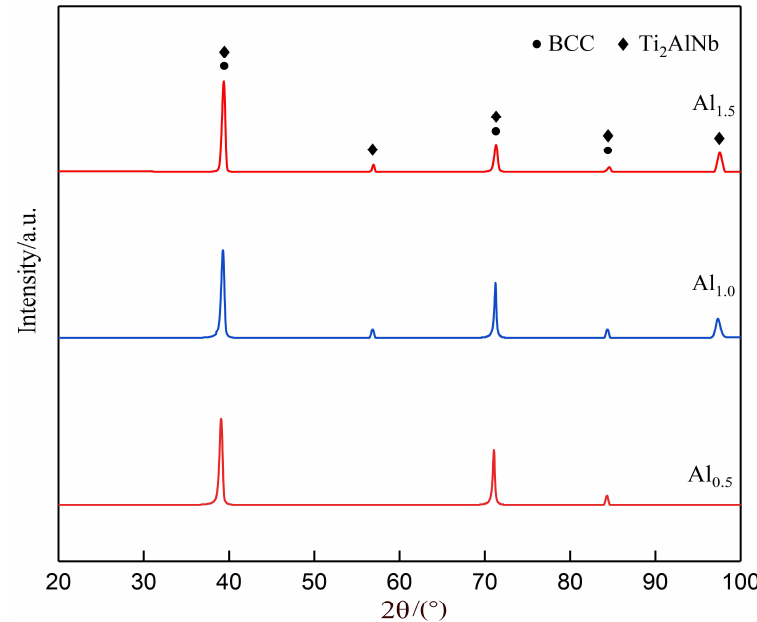
Figure 2. X-ray diffraction patterns of Al x MoNbTa RHEAs coatings. Table 1. The mixing enthalpy ( ∆ H mix , KJ/mol) calculated for each pair of elements [58].